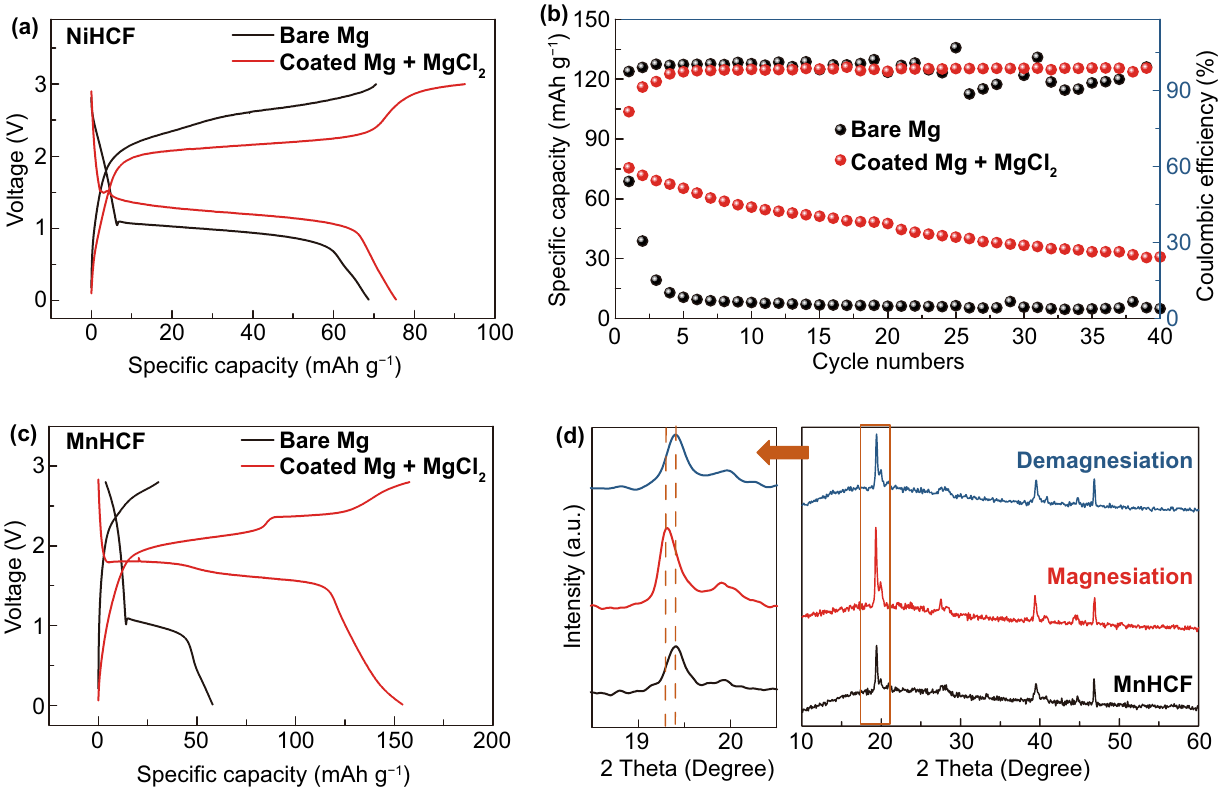
Fig. 4 Electrochemical performance of full cells: a charge–discharge curves and b cycling performance at 0.1C for NiHCF/bare-Mg and NiHCF/Coated Mg + MgCl 2 full cells. c charge–discharge curves at 0.1C for MnHCF/bare-Mg and MnHCF/coated Mg + MgCl 2 full cells. d XRD patterns for MnHCF at the different states of